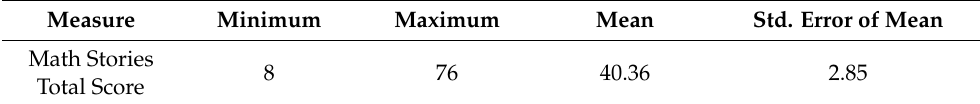
Table 1. Math Sharing Stories Descriptive